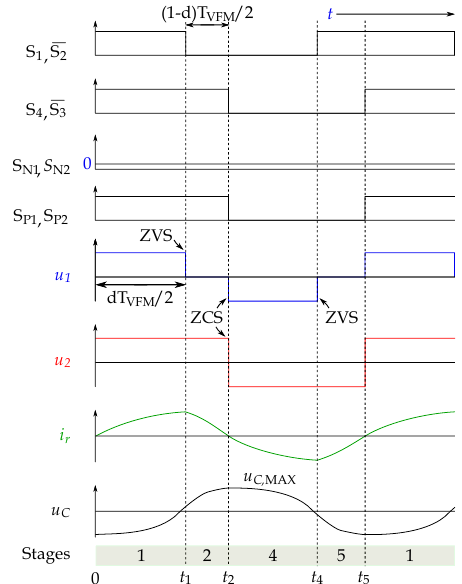
Figure 4. Key waveform of the proposed converter with